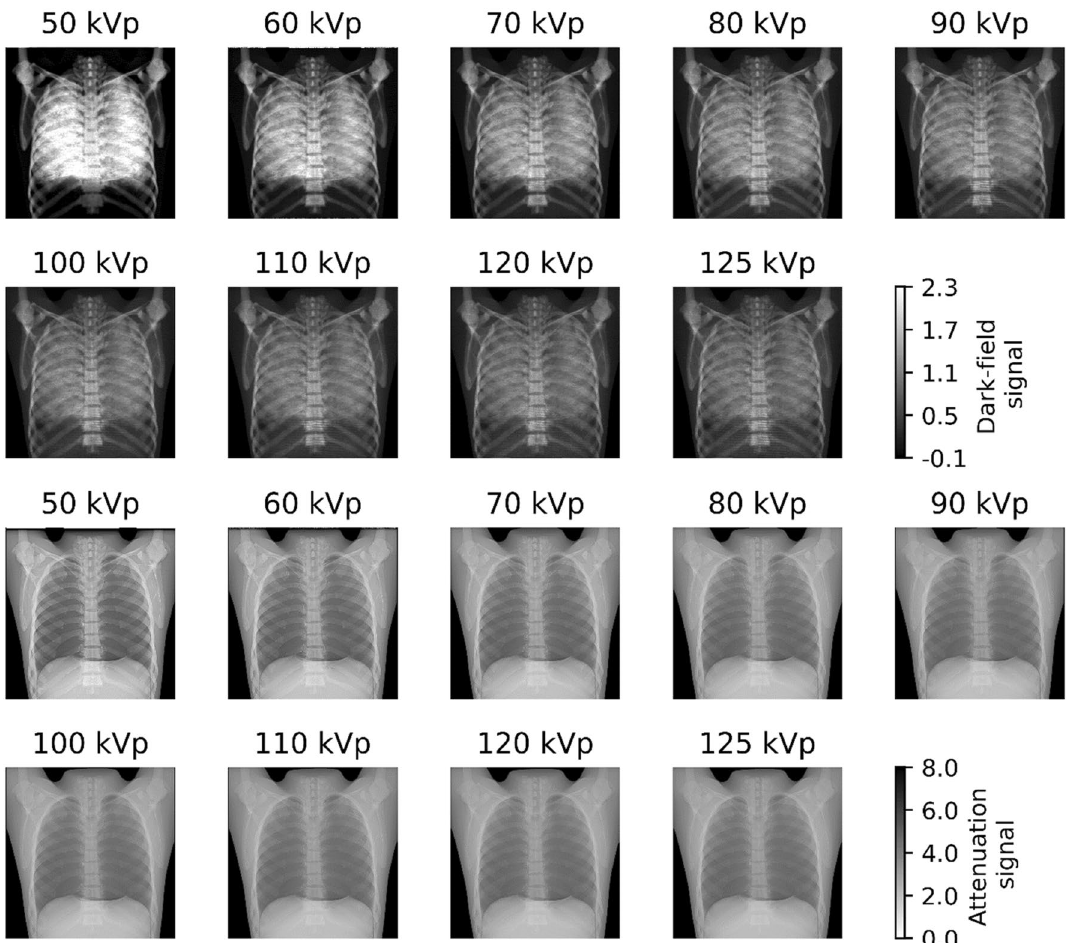
Figure 1. Dark-field (top) and attenuation radiograph (bottom) images acquired with different tube voltages. A distinct decrease in dark-field signal strength can be seen towards higher tube voltages. At lower tube voltages, a higher opacity of bone is present in attenuation radiographs, impairing the visualization of the